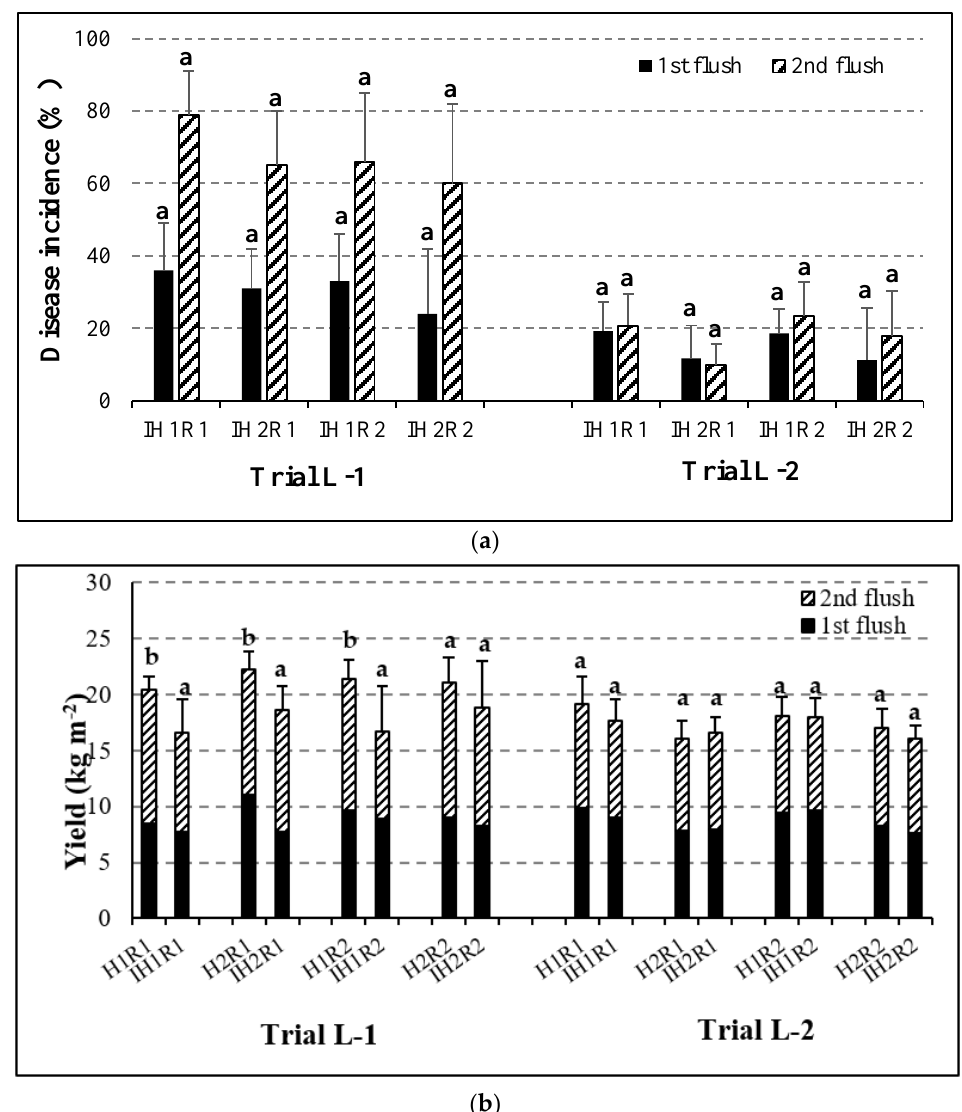
Figure 2. Pathogenic with artificial infection of Lecanicillium fungicola (L-1 and L-2). ( a ) Incidence; ( b ) Yield. H1R1, low initial water content with a light irrigation program; H2R1, high initial water content with a light irrigation program; H1R2, low initial water content with a moderate irrigation program; H2R2, high initial water content with a moderate irrigation program. I in treatment means artificially inoculated with the parasite. (*) For each trial and flush, the same letters show no significant differences according to Tukey’s HSD test at P = 0.05.